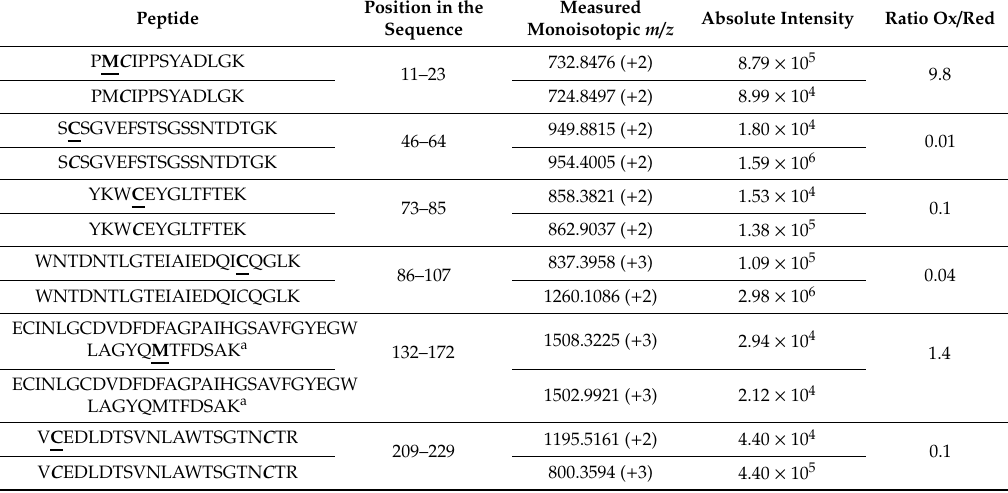
Table 2. Comparison of the absolute intensities of molecular ions of selected sulfur containing tryptic peptides found in the analysis of hVDAC2 reduced with DTT, carboxyamidomethylated, and digested in-solution. Position in the Measured Peptide Sequence Monoisotopic m /